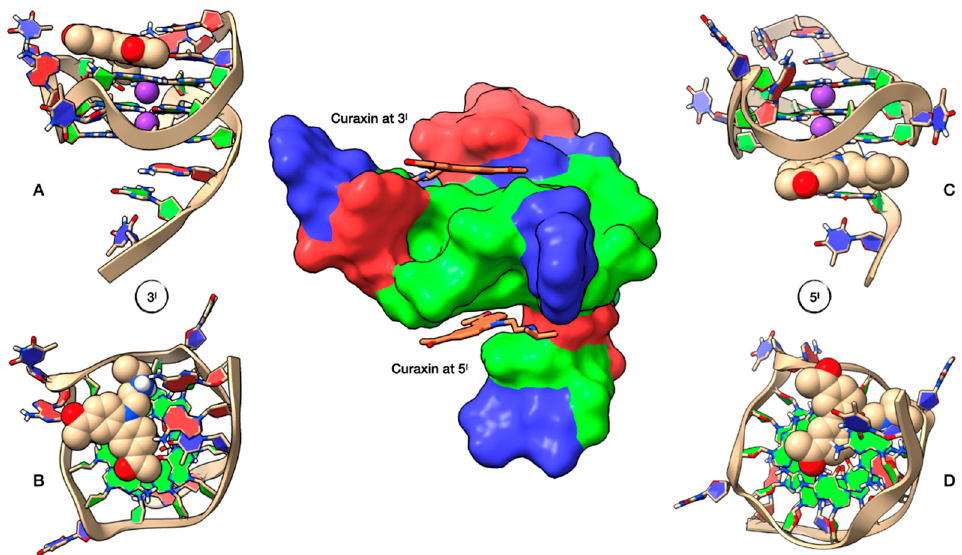
Figure 7. Representation of the Pu22T14T23 complexes with curaxin at 5’-end and 3’-end, obtained by Molecular Docking and optimized by Molecular Dynamics (MD). At the center of the figure Pu22T14T23, represented by its solvent accessible surface (SAS), color-coded by the underlying nucleotide (adenine in red, guanine in green and thymine in blue) and complexed with curaxin (represented in stick) at both 3’-end and 5’-end. On the left, lateral ( A ) and top ( B ) representation of the ligand conformation at the 3’-end, while on the right we can see the lateral ( C ) and bottom ( D ) representation of curaxin at the 5’-end. Ligand and potassium ions are represented by their van der Waals spheres (ligand colored in CPK, K + in purple), while the nucleotide units of Pu22T14T23 are represented as filled rings: adenine in red, guanine in green and thymine in blue.